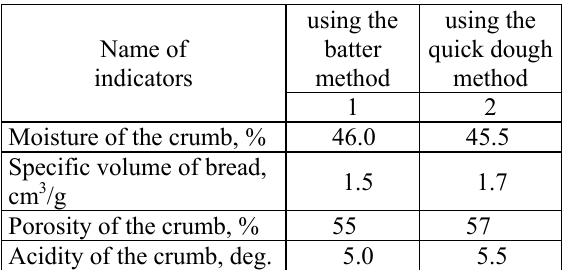
Table 7 . Moisture and deformation indicators of bread crumb during storage